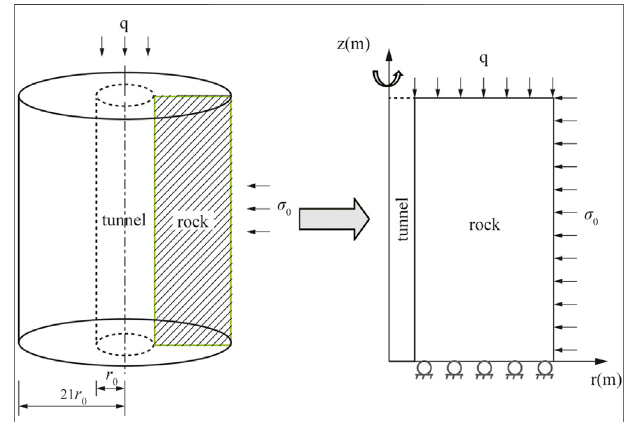
FIGURE 4 | Two-dimensional axisymmetric numerical model. FIGURE 5 | Comparison results with numerical